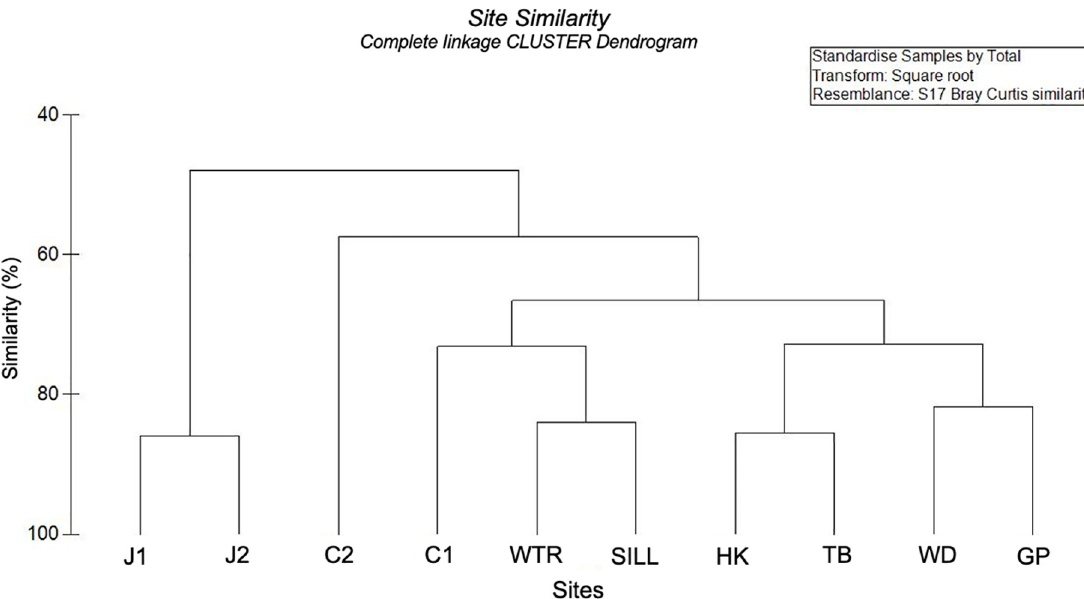
Fig 6. Site similarity dendrogram. This complete-linkage CLUSTER analysis dendrogram was constructed from a Bray-Curtis similarity matrix calculated from percent coverage data, which were standardized and square-root transformed for analysis.